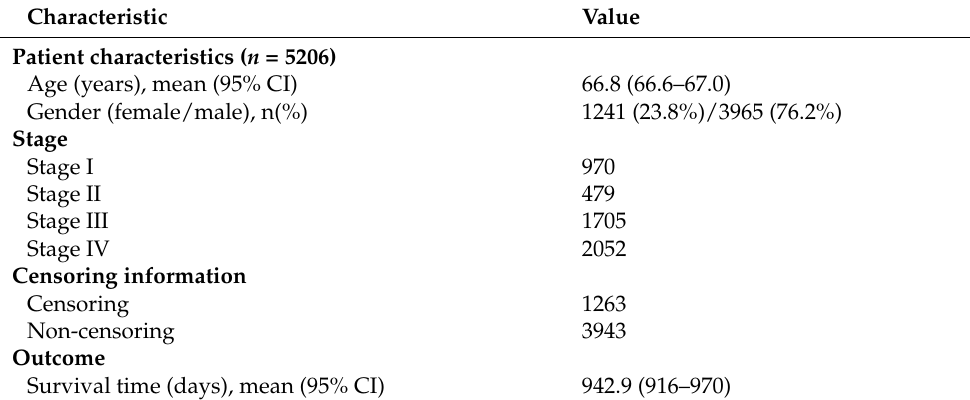
Table 1. Patient characteristics ( n = 5206) (CI: confidence interval).